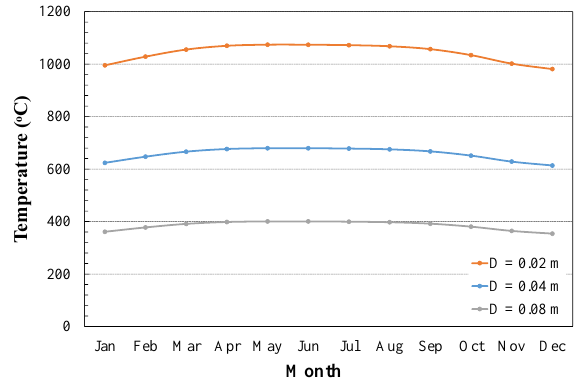
Figure 3. Maximum theoretical temperature reached by the re- ceiver as a function of its absorber diameter.